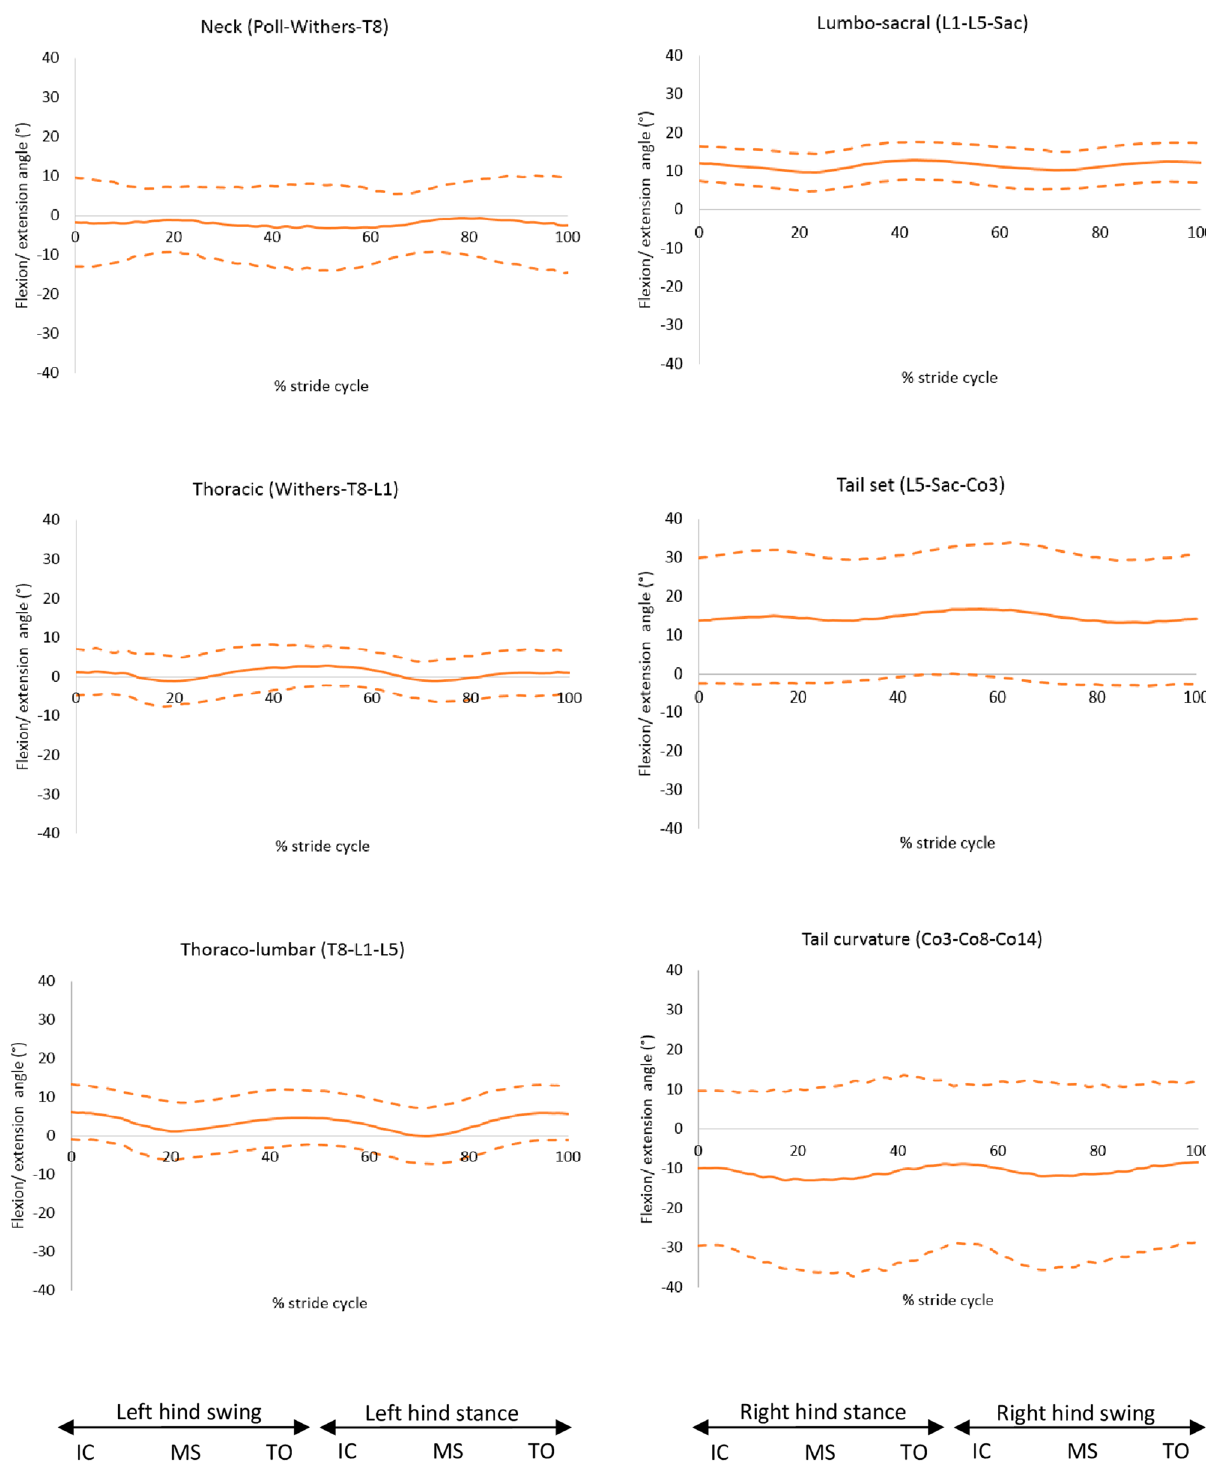
showing initial contact (IC), Mid Stance (MS) and Toe Off (TO) for the left (right hind stance/left hind swing) and right diagonals (left hind stance/right hind swing). Between brackets: marker names (Supplementary material 3,